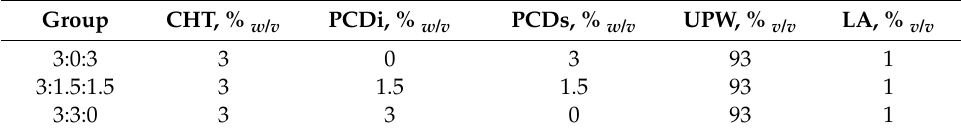
Table 1. Formulations for preparing the CHT/PCDi/PCDs